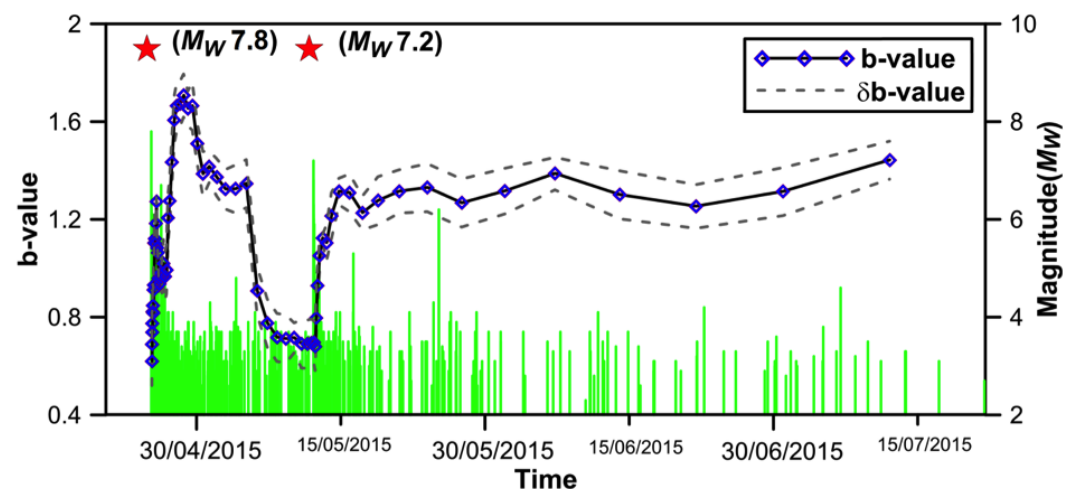
Figure 6. Temporal variation of b -value for the studied region. Dashed lines indicate the standard deviation and stars mark the times of oc- ≥ 7. Solid, vertical lines represent the time of occurrence and magnitude (right scale) of all recorded currence of Nepal earthquakes for M W earthquakes. Date format: